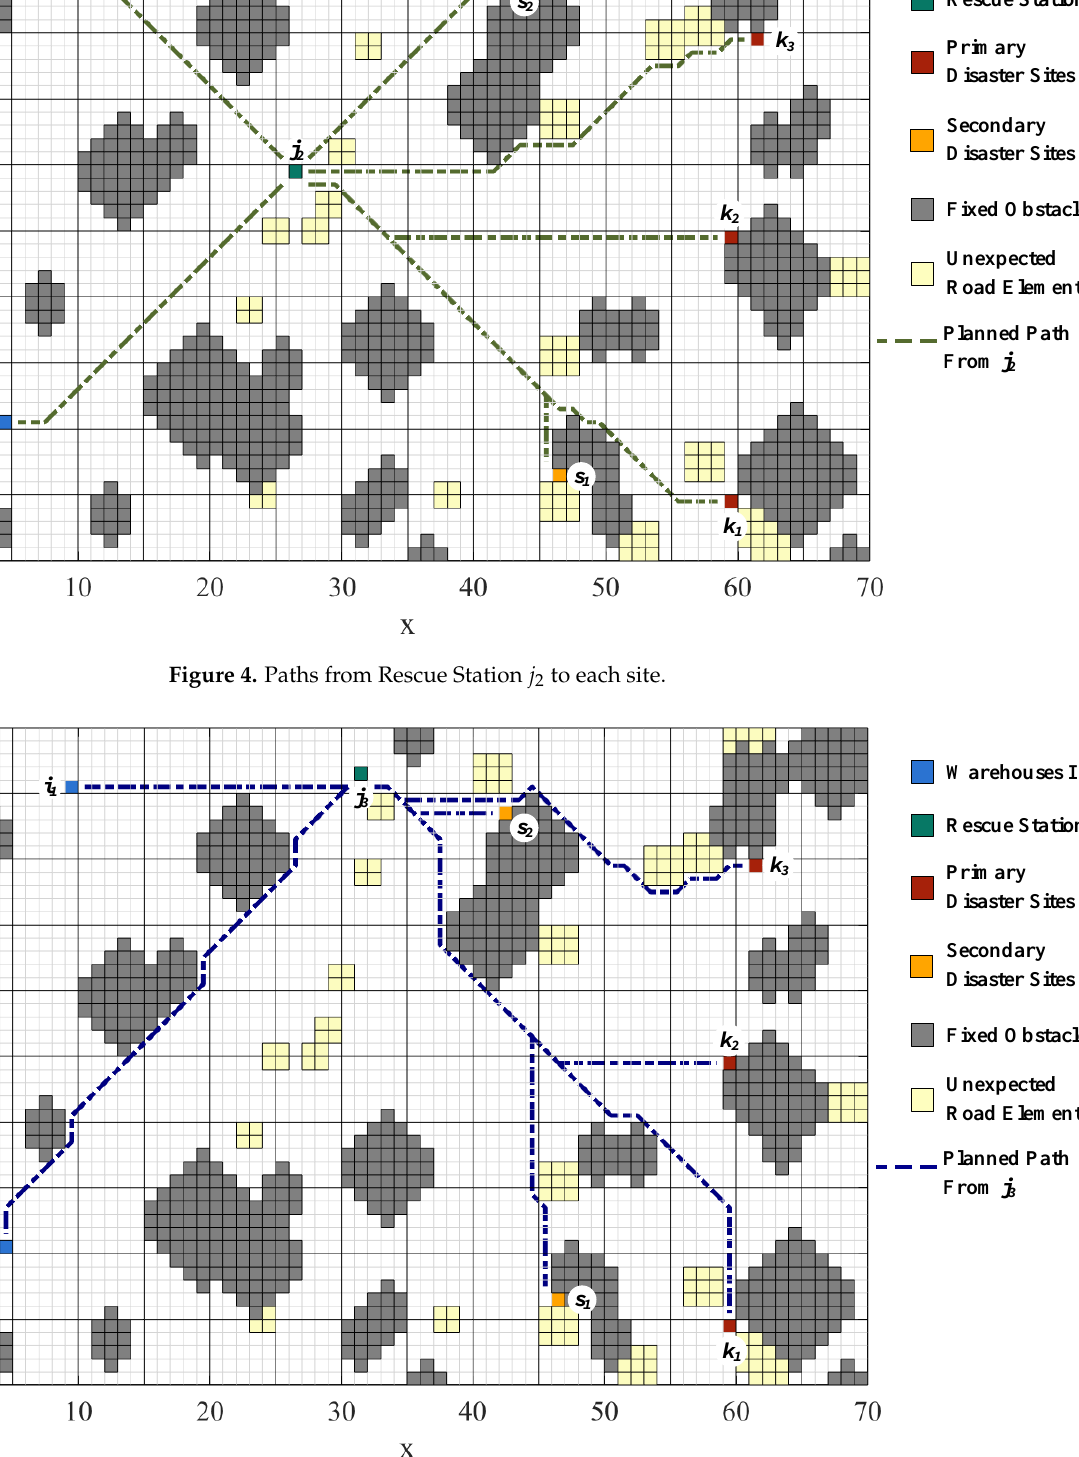
Figure 5. Paths from Rescue Station j 3 to each